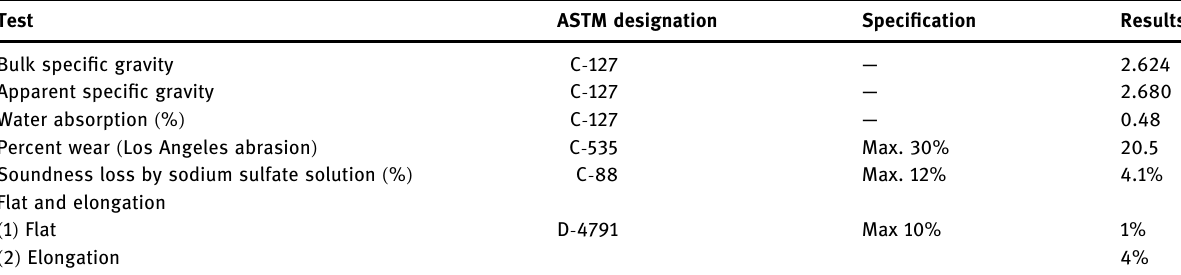
Table 1: Physical characteristics of coarse aggregate